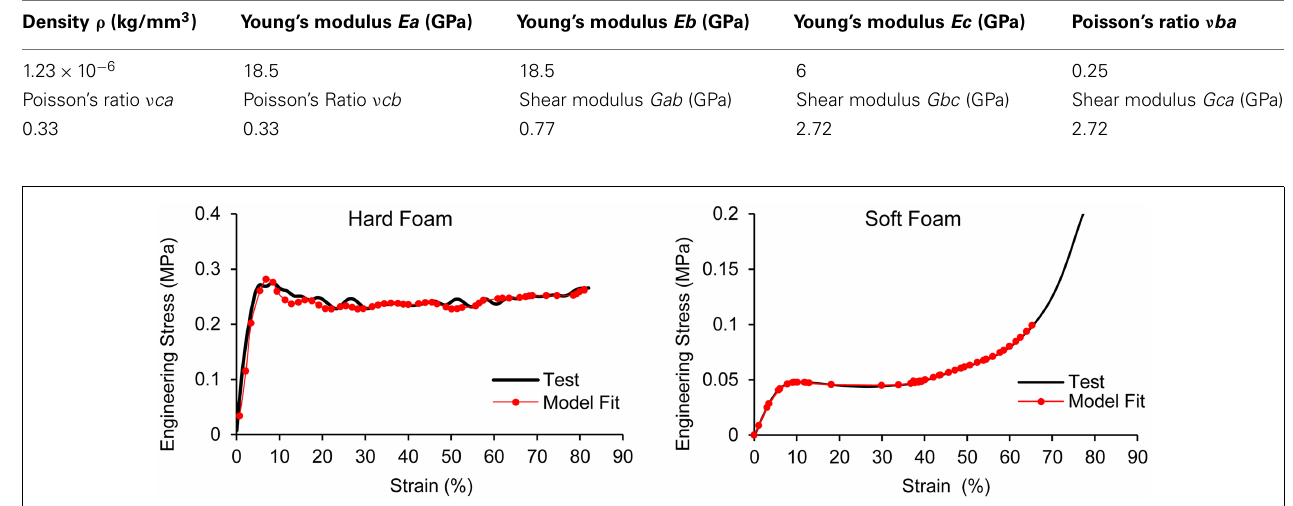
FIGURE 2 | Stress-strain data and model fit for the hard and soft foams